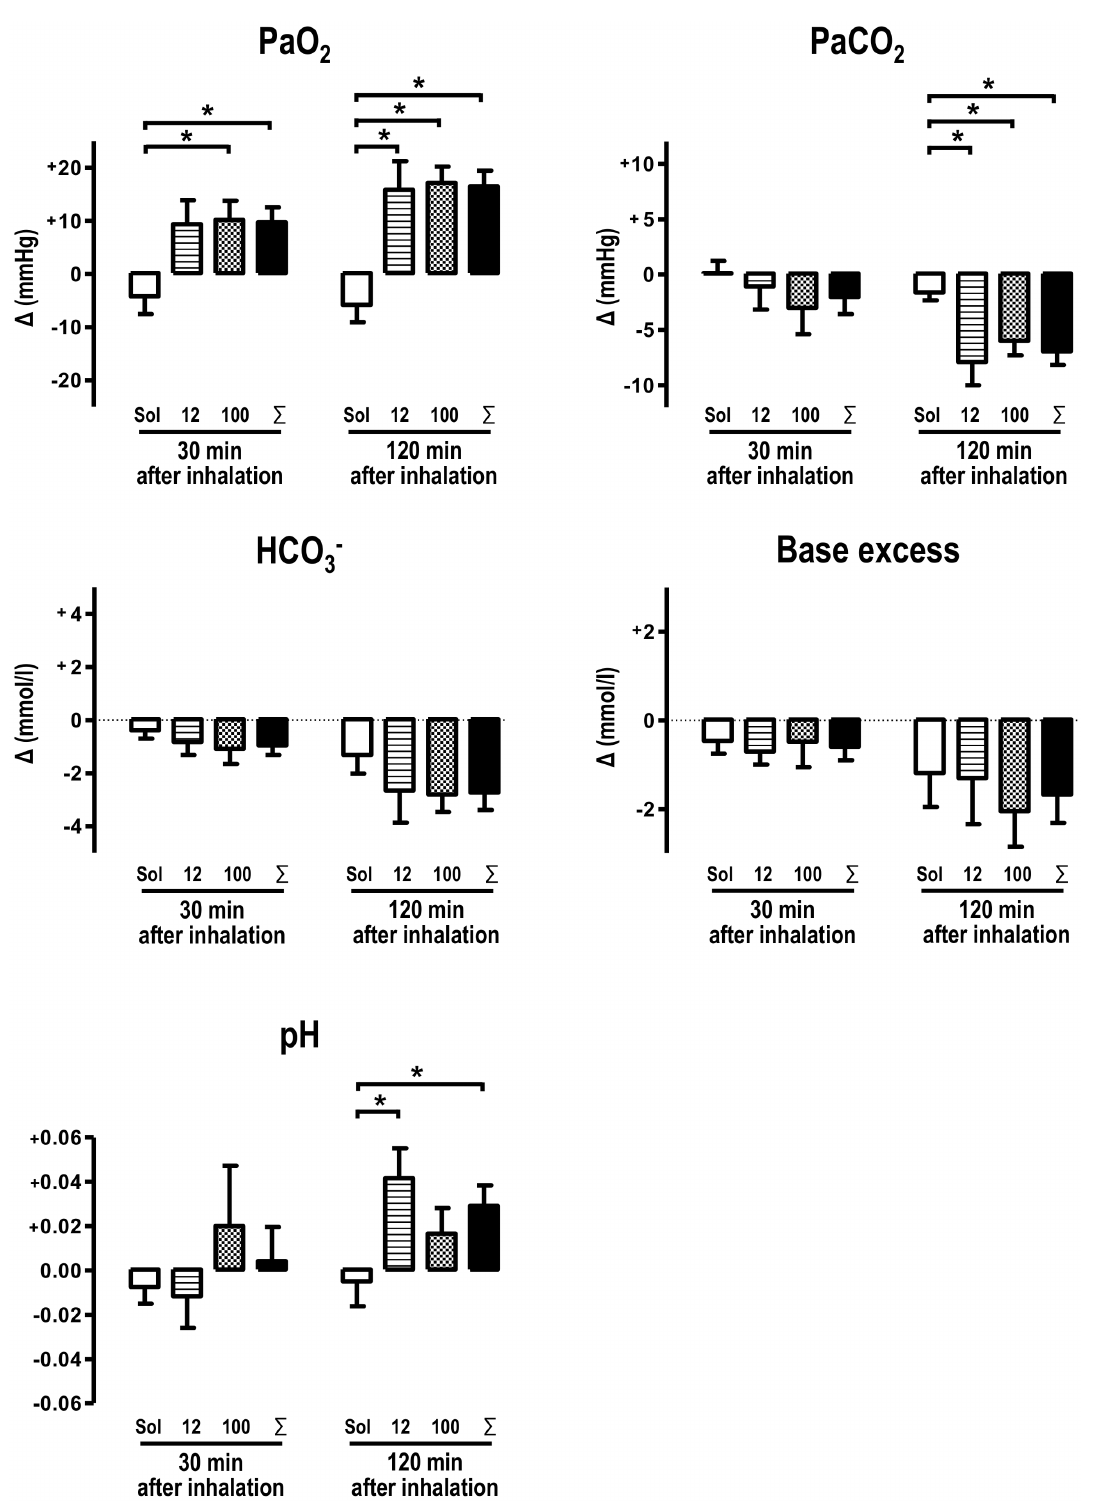
Figure 2. Blood gas analyses. 12 m M and 100 m M NS1619 improved oxygenation (PaO 2 ) considerably 120 minutes after inhalation and 100 m M and g NS1619 data exhibits a significant increase already 30 minutes after NS1619 inhalation. Carbon dioxide levels (PaCO 2 ) were attenuated 120 minutes after NS1619 inhalation. 12 m M and g NS1619 data demonstrate an elevated pH 120 minutes after inhalation. Base excess (BE) and bicarbonate concentration were not altered significantly by NS1619 although HCO 3 2 was attenuated in NS1619 treated animals at least by trend. Data obtained after inhalation were subtracted from individual basis values and individual value differences ( D ) were calculated for each animal and time point. (Solvent: n=8; 12 m M: n=6, 100 m M: n=6, g NS1619: n=12; *: p , 0.05).